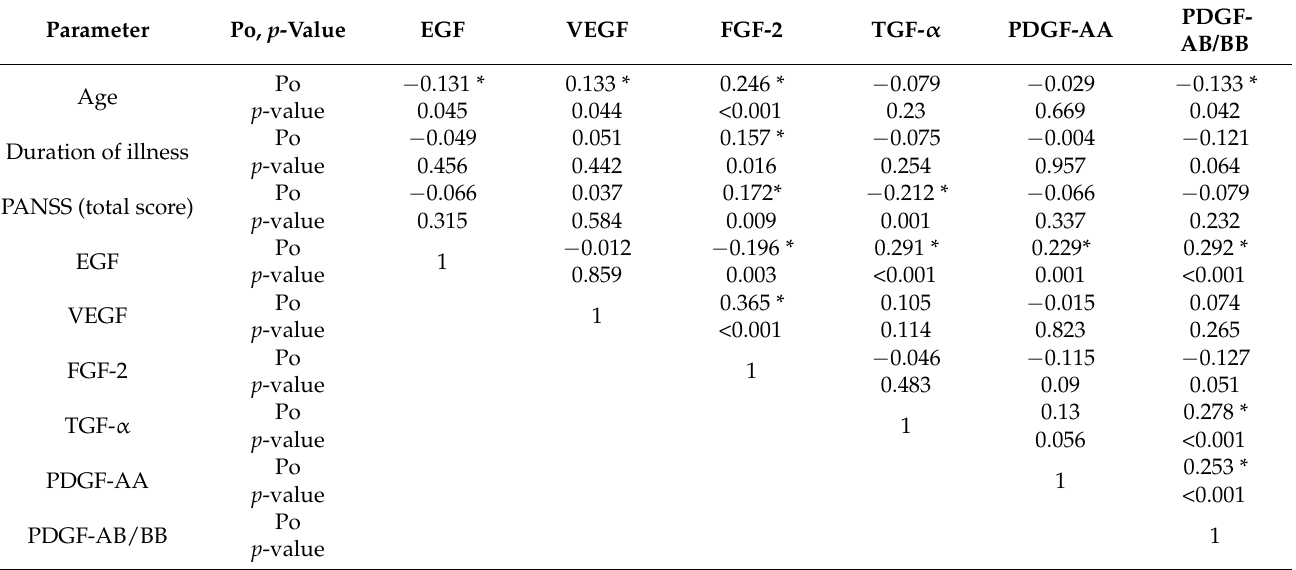
Table 7. Spearman’s correlation analysis between growth factors, age, duration of illness and PANSS score in schizophrenia